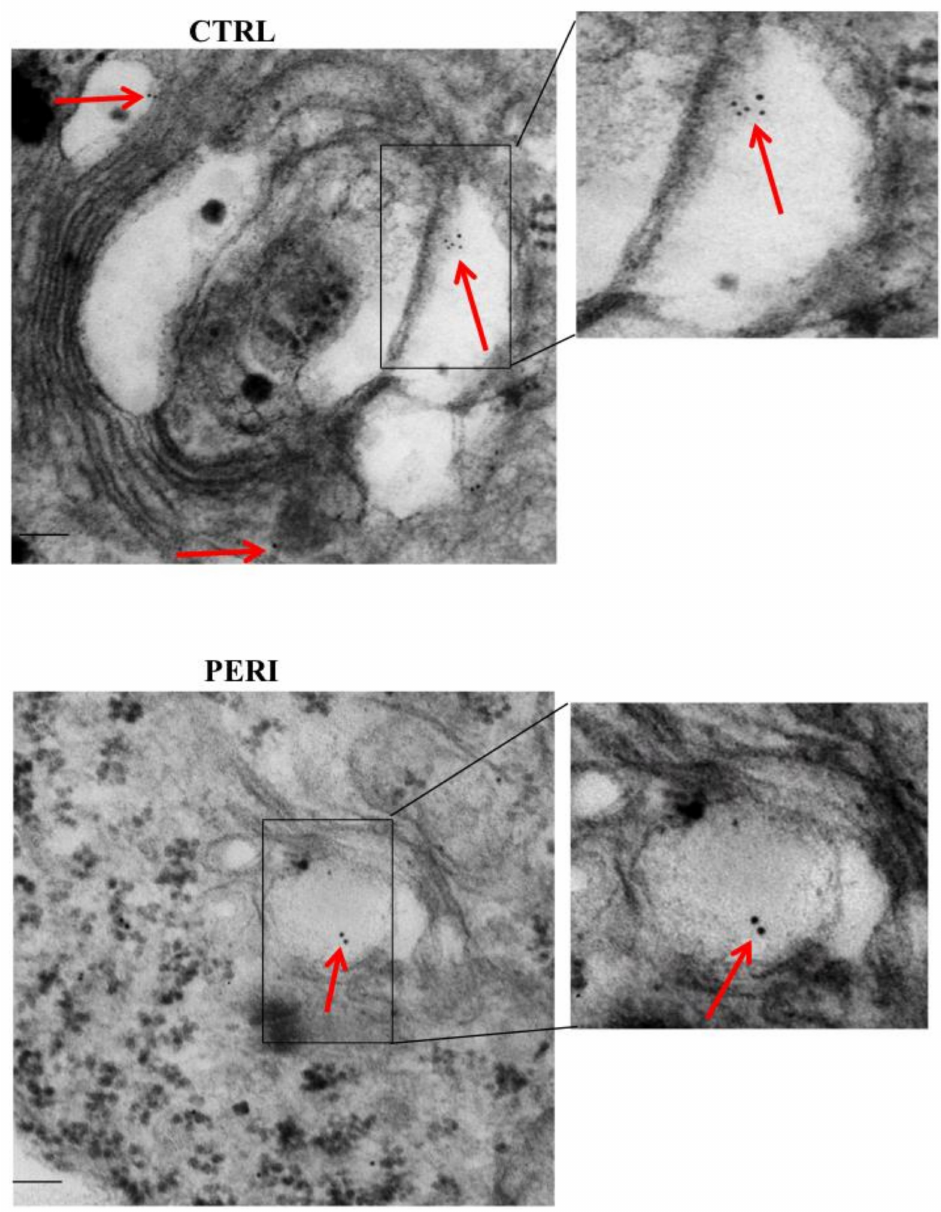
Figure 5. Representative polarization for HSP70. Representative TEM micrograph showing HSP70-positive vacuoles from the control cortex ( CTRL ) and the penumbra cortical area ( PERI ). Arrows point to HSP70 immuno-gold particles within vacuoles. The insert highlights the immuno-gold particles within vacuoles. Scale bar = 0.2 µ m (low magnification), 0.1 µ m ( inserts